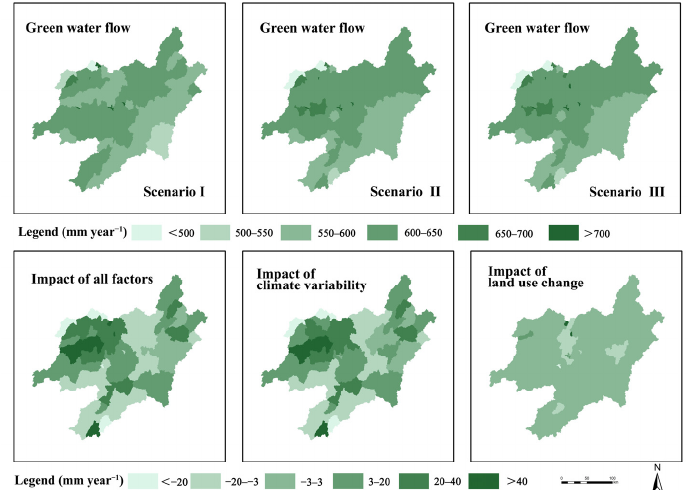
Figure 7. Spatial distribution of GWF and change in GWF in the upper Ganjiang River basin under the individual or combined influence of climate and land-use change.